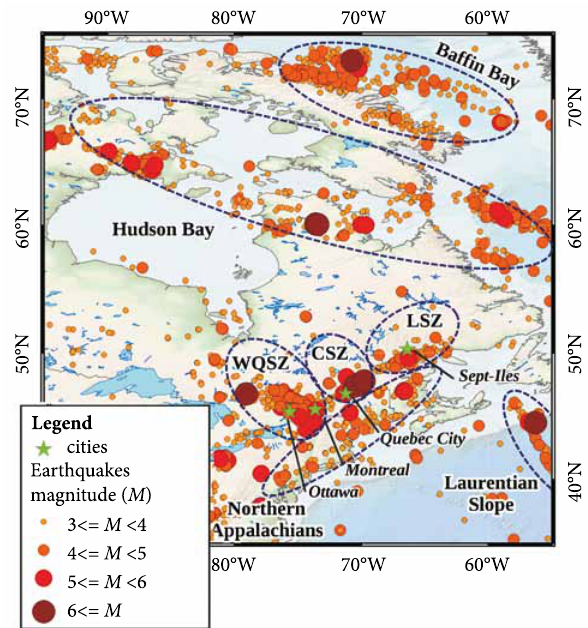
Fig. 1. Instrumental earthquakes with M ≥ 3 recorded from 1945 until mid-2014 and historical earthquakes estimated since 1663 in eastern Canada (data source: Earthquake Canada and the Advanced National Seismic System of the United States). The clusters of seismic activities are delineated as well as the seismic zones along the Saint Lawrence River